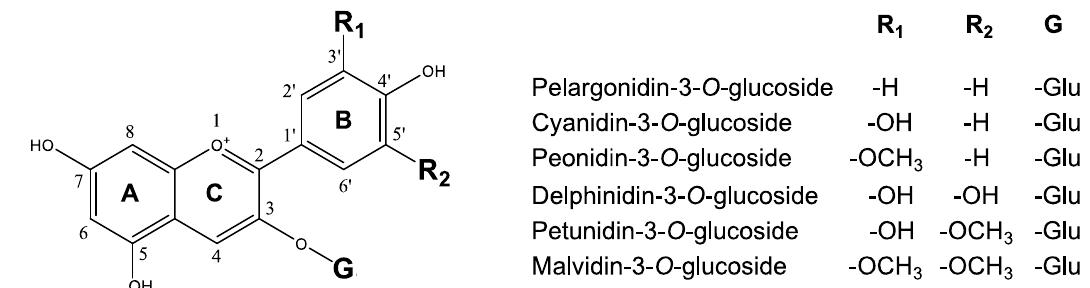
Figure 1. Basic structure of the six most common anthocyanidins.